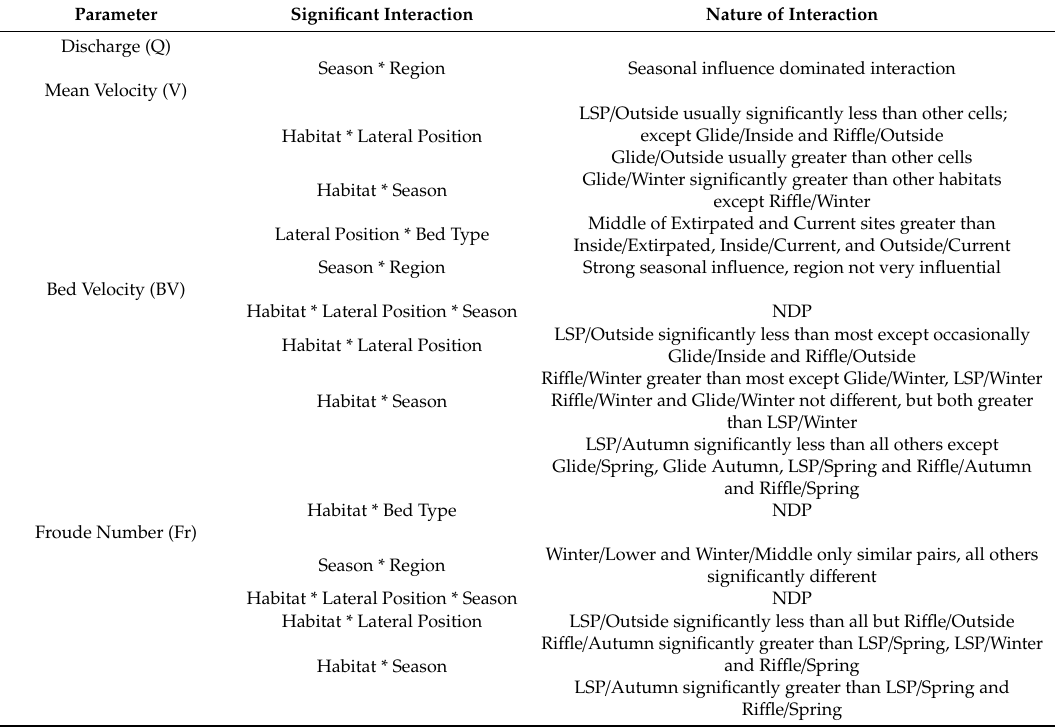
Table 3. General trends identified through interactive e ff ects testing (Tukey’s HSD). Only significant interactions are listed (NDP = No Discernable